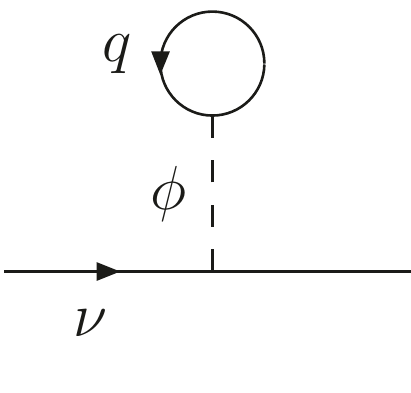
Figure 1 . One-loop contribution to neutrino Figure 1: One-loop contribution to neutrino mass